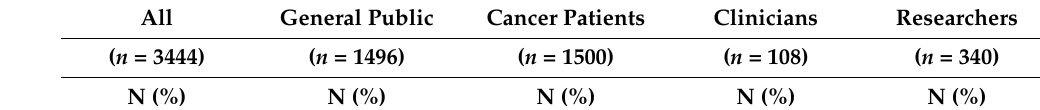
Table 5. Univariate logistic regression analysis of variables associated with intent to undergo risk- reducing